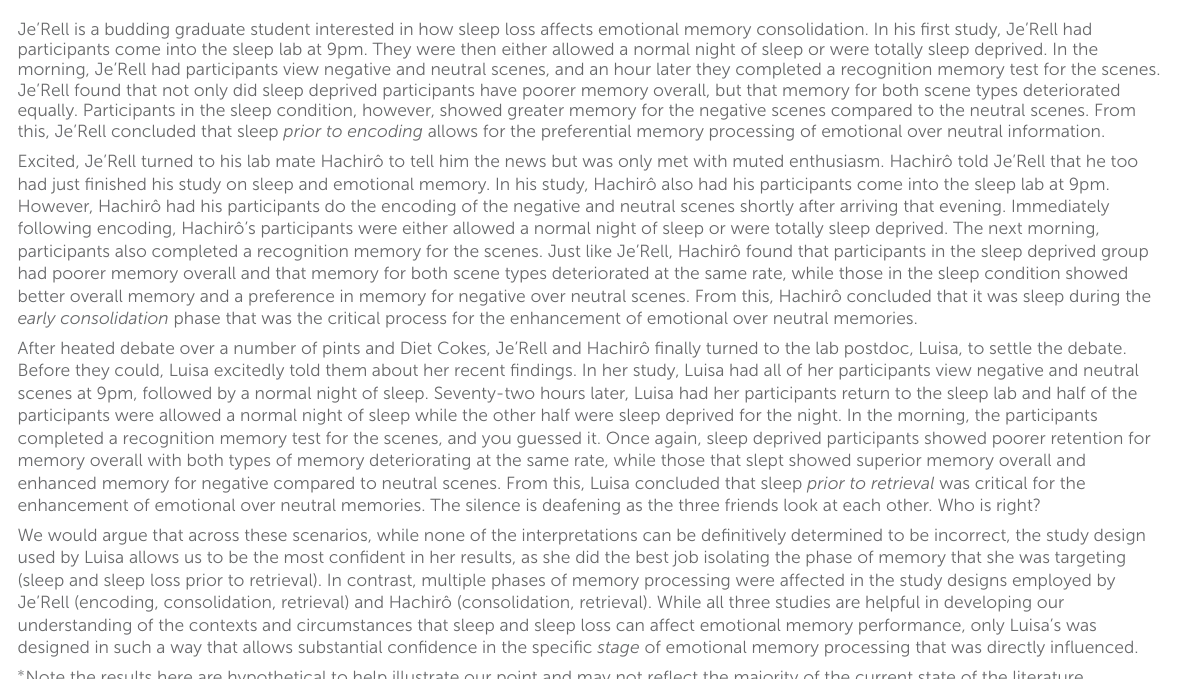
BOX2 Demonstration of the